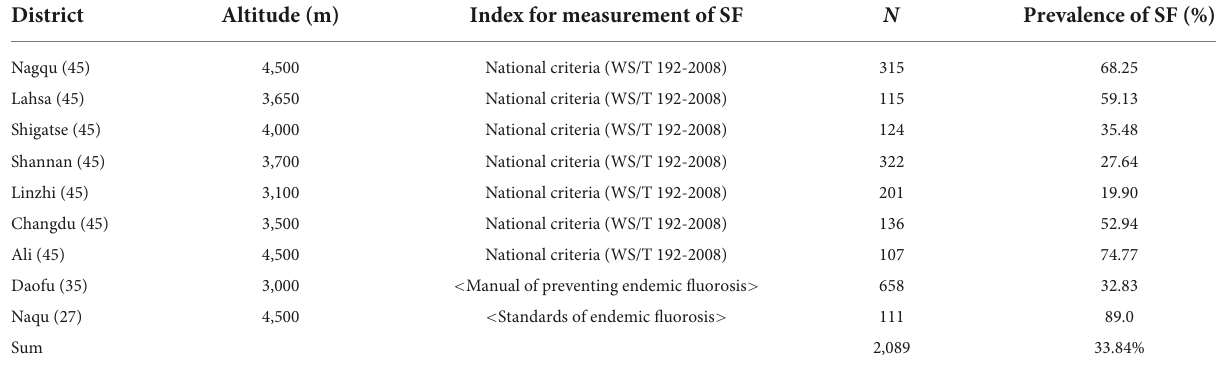
TABLE 4 Prevalence of skeletal fluorosis in different